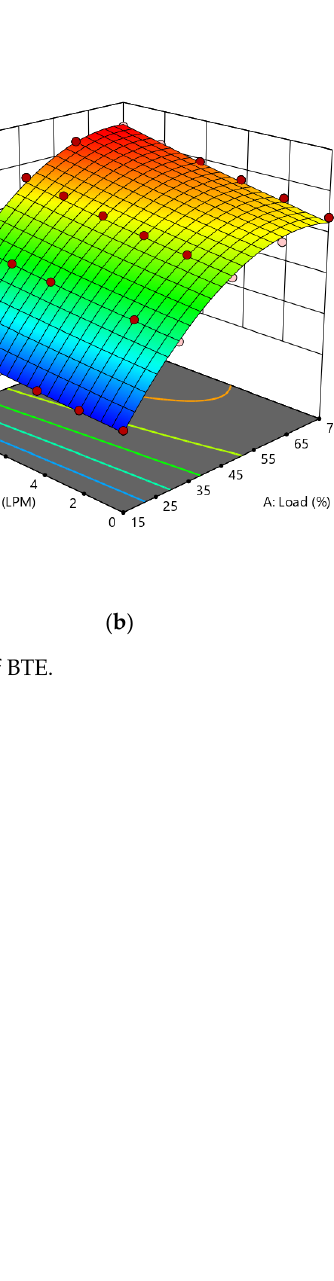
Figure 3. Comparison of actual and predicted BTE. Table 5. ANOVA results for